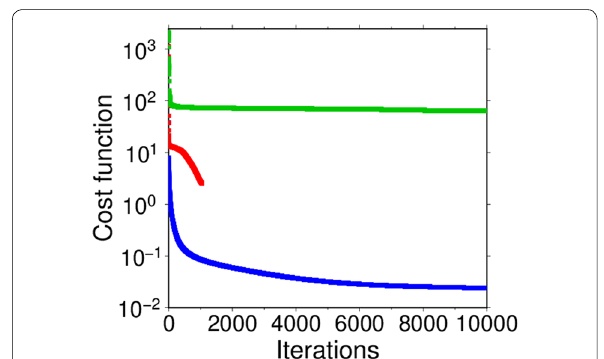
Fig. 4 Cost function. The blue line indicates the changes in the cost function values calculated using Eq. (7) with the number of iterations in Exp. 1. The red and green lines are those in Exps. 1-(i) and 1-(ii) mentioned in the